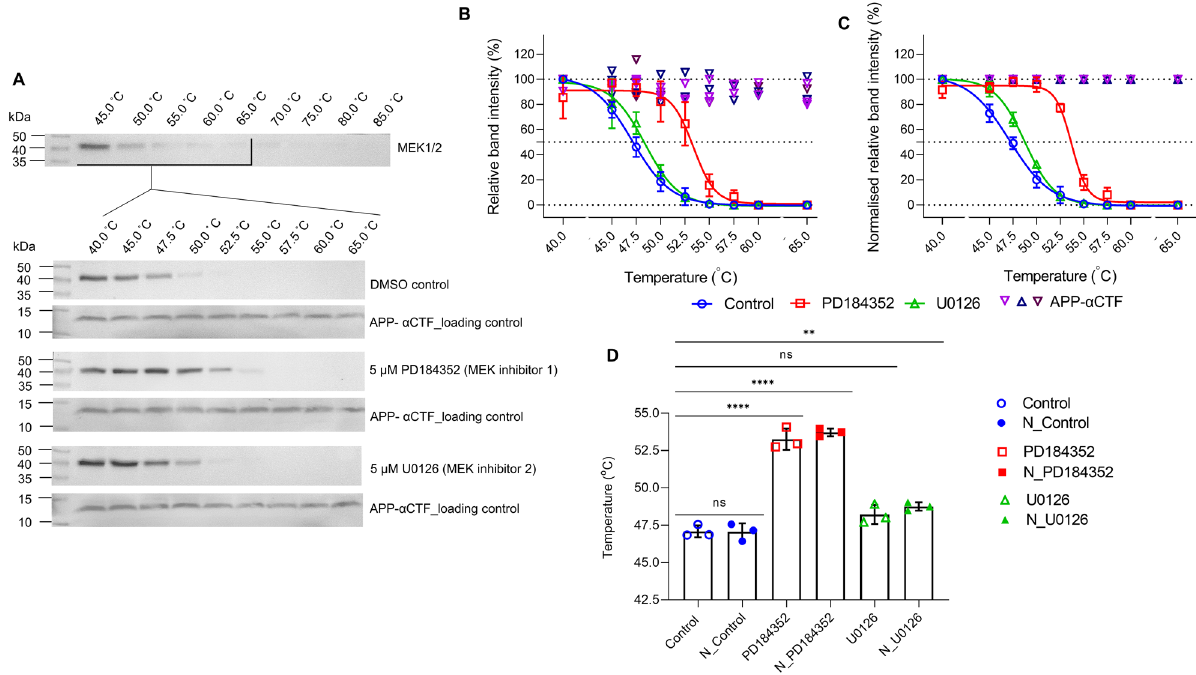
Figure 5. The cellular thermal shift assay of MEK in the presence of inhibitors, PD184352 and U0126 showcasing the use of APP-αCTF as a temperature insensitive loading control. ( A ) A representative cropped western blot of MEK in the soluble fraction from HEK293 cell lysate after treatment with 5 µM inhibitor (PD184352 (open red square) or U0126 (open green triangle)) for 4 h and subsequent temperature exposure (initial broad range 45–85 °C followed by final narrow range 40–65 °C) as compared to a DMSO vehicle control (open blue circle). The corresponding sigmoidal curves (mean ± SD) as determined by relative band intensity ( B ) or normalised (N) relative band intensity, to APP-αCTF loading ([ ]) ( C ), calculated by setting the highest intensity for each data set as 100% and the curve generated using the Boltzmann sigmoidal equation are shown with ( D ) the mean aggregation temperature (Tagg) ± SD, pre-normalised (open symbol) vs normalised (N—solid symbol) (n = 3). One-way ANOVA with Tukey’s post-hoc was performed where ns, not